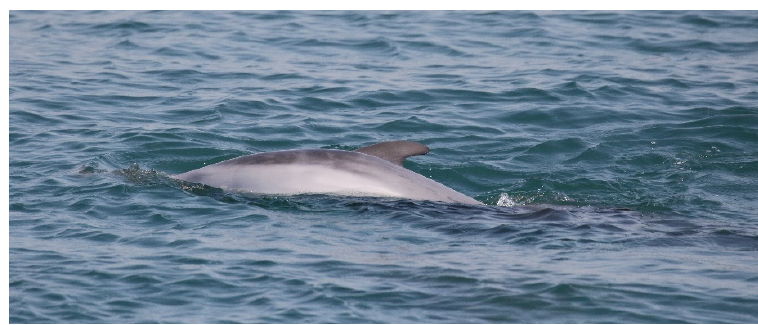
Figure 7. Carcass of the calf with the fetal folds still visible and inflated belly.